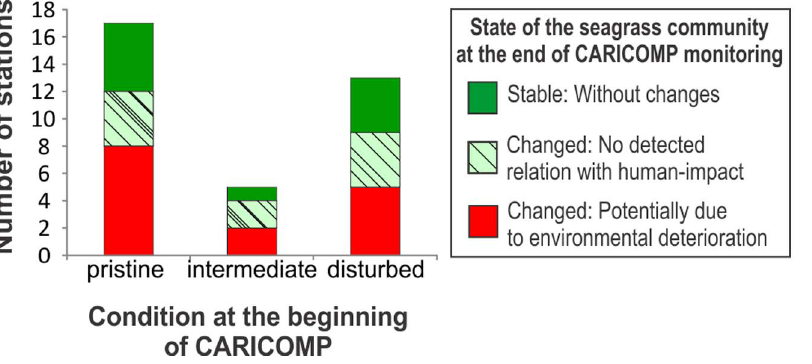
Figure 6. State of the long-term monitoring stations at the beginning (1993) and end (2007 – 2012) of the CARICOMP program. Pristine: Relatively undisturbed stations at the start of the program. Intermediate: Stations moderately disturbed by human-impact at the beginning of the program. Disturbed: Stations which had undergone chronic human-induced impacts before the initiation of the monitoring program.